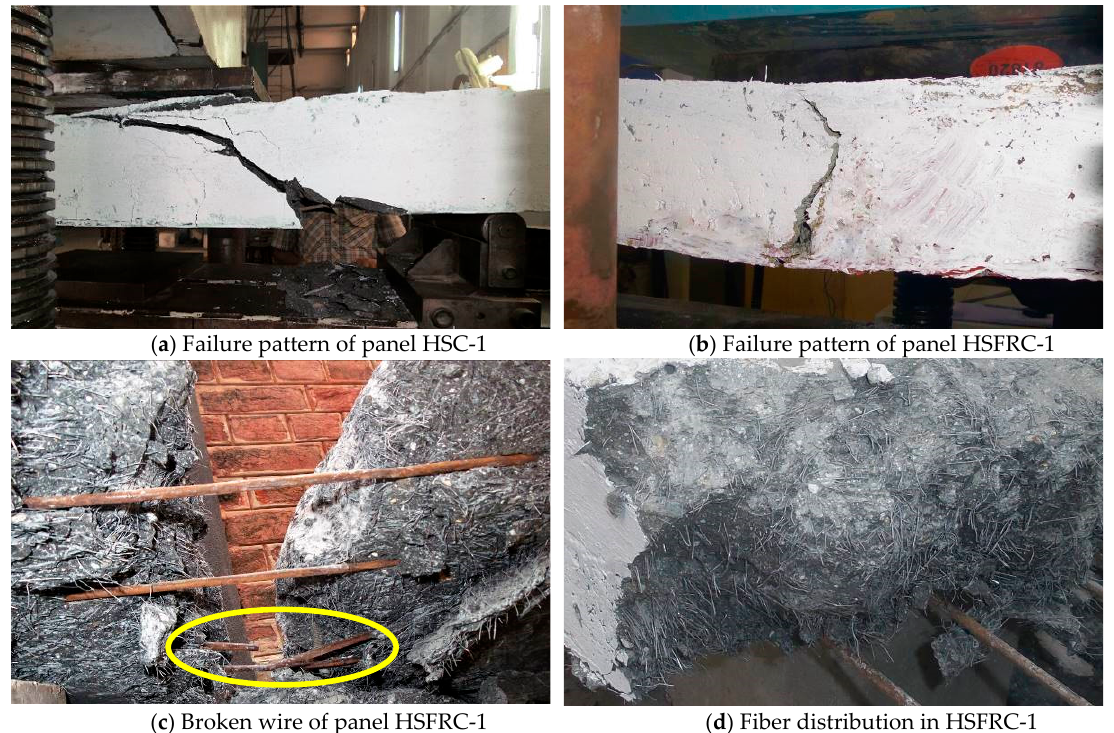
Figure 8. Failure pattern and forensics of prestressed panels.